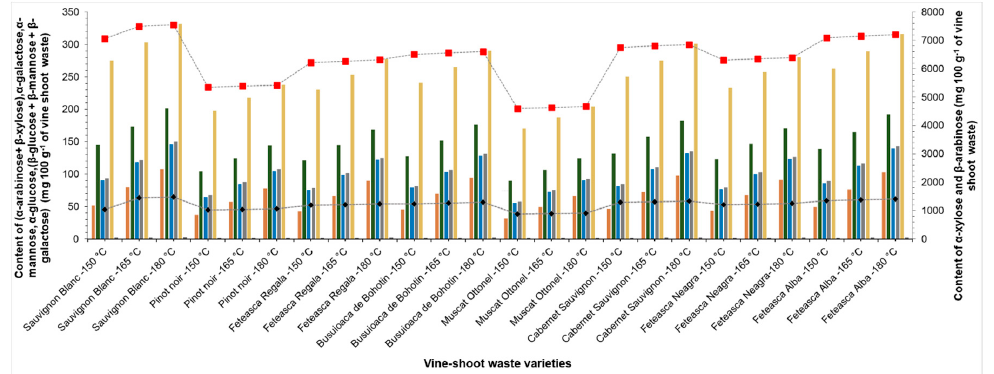
Figure 1. Content of anomers from vine-shoots waste hemicellulosic sugars as functions of the vine plant varieties ( α -arabinose + β -xylose, α -galactose, α -mannose, α -glucose, a β -glucose + β -mannose + β -galactose, β -arabinose and α -xylose).